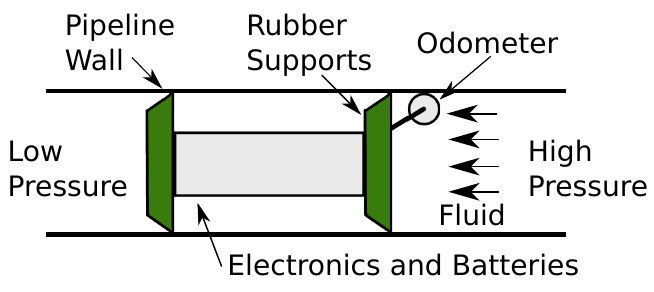
Figure 1. An example of the PIG inserted in the pipeline. Source: Edited by